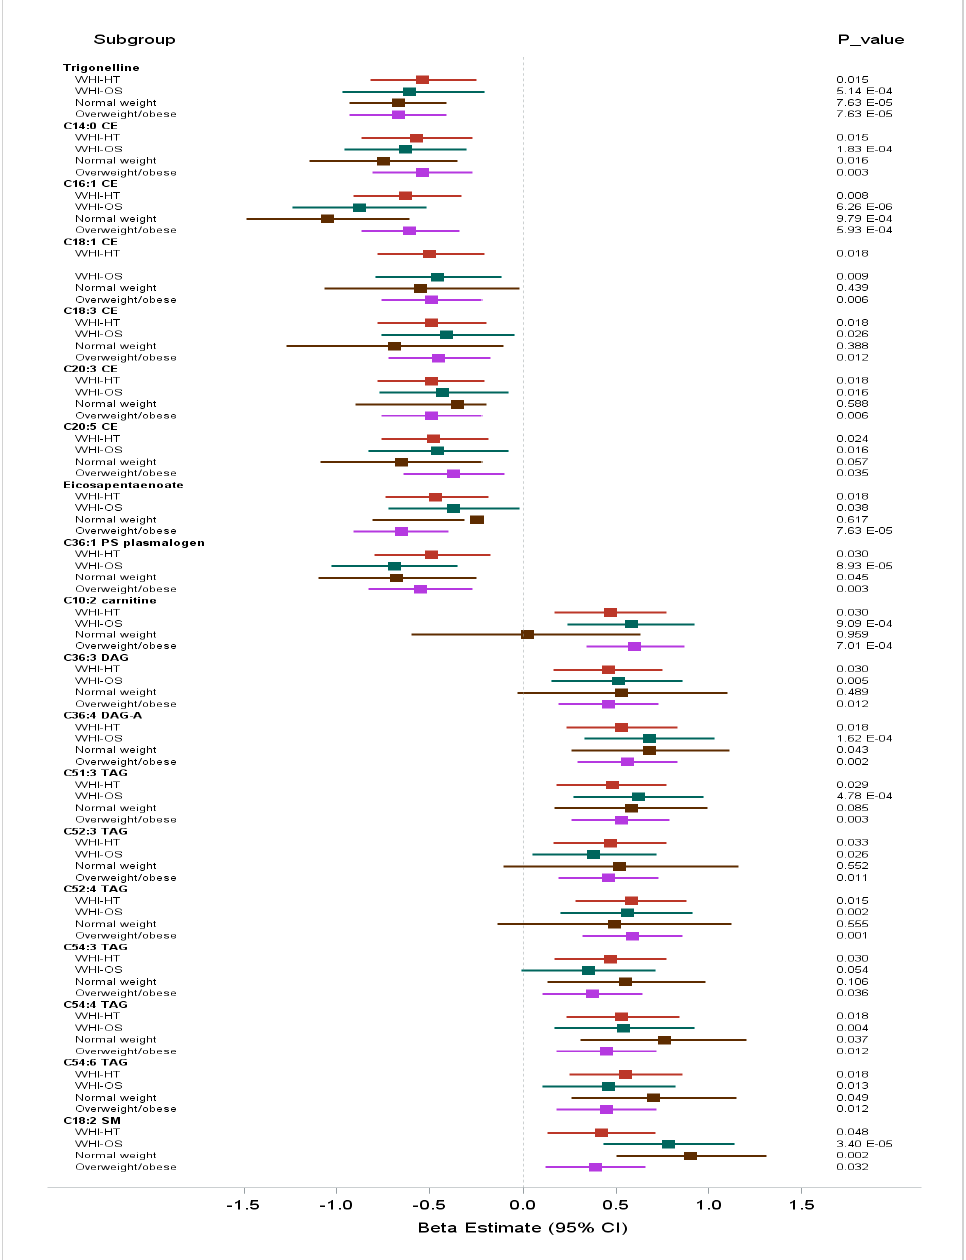
Figure 2. Summary of EDIH associations with the 19 replicated metabolites in the discovery (WHI-HT) and replication (WHI-OS) datasets and in body mass index categories. Associations were adjusted for body mass index (continuous) age, physical activity, educational level, race/ethnicity, aspirin/NSAIDs use, smoking status, WHI Hormone Therapy trial arm, and CHD case-control status. P-value is the FDR-adjusted p-value.